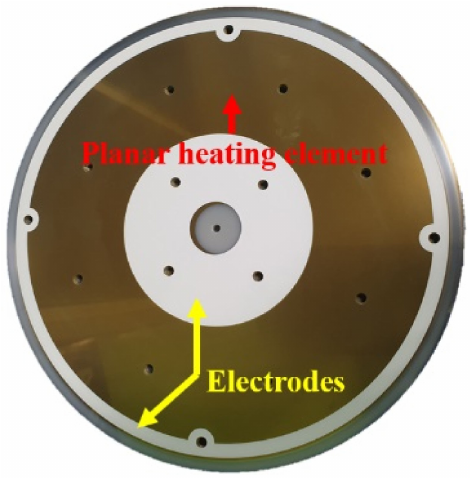
Figure 6. Heating part of the PHC prototype heat-treated at 550 ◦